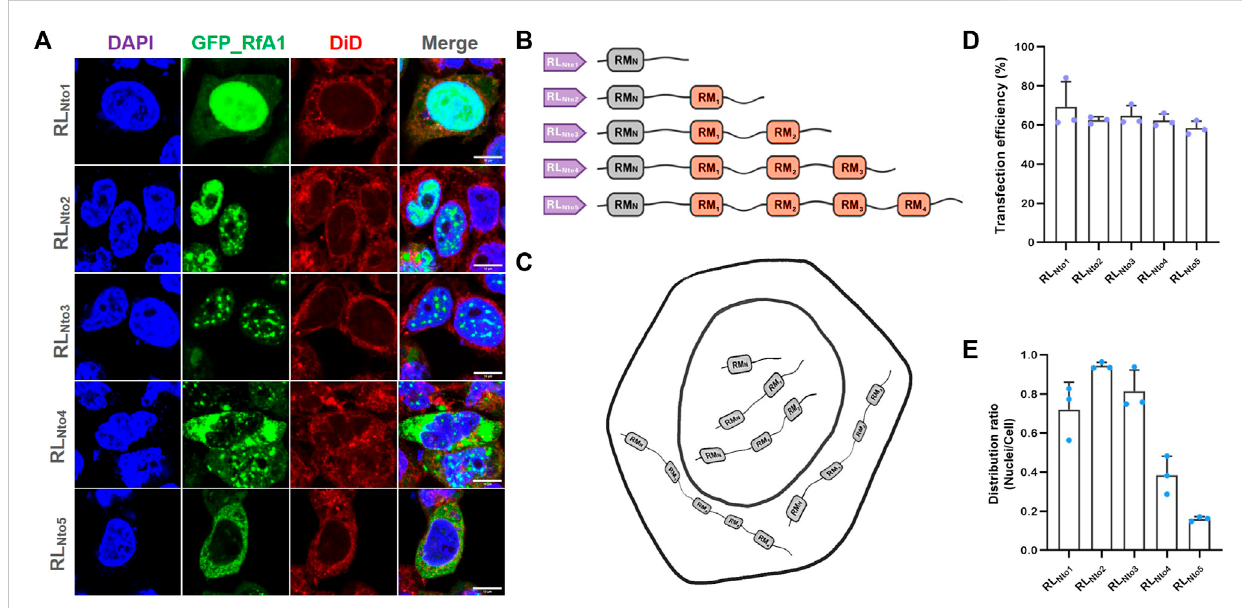
FIGURE 2 Recurrence of phase separation and cyto-/nucleo-localization preferences of RfA1-derived peptides in fi xed HEK-293T cells. (A) Nuclei and membrane are stained with DAPI (blue) and DiD (red), and RfA1-derived peptides are indicated by tandem EGFP (green). Scalebars = 10 μ m. (B) Schematics of RfA1 derivatives. (C) Illustration of subcellular localization of RL Nto1 , RL Nto2 , RL Nto3 , RL Nto4, and RL Nto5 . (D) Cell number statistics and quanti fi cation oftransfection ef fi ciencies ofRL Ntox (x=1,2, 3,4, and5). (E) Distributionratiostatisticsof fl uorescentintensity intransfected cellsand theirnuclei(seeSupplementaryFigureS4forlarge-areaimmuno fl uorescenceimagesandSupplementaryFigureS3forCellviabilitytestedbyCCK-8kits). Data are presented as mean values ±SD for n = 3 independent